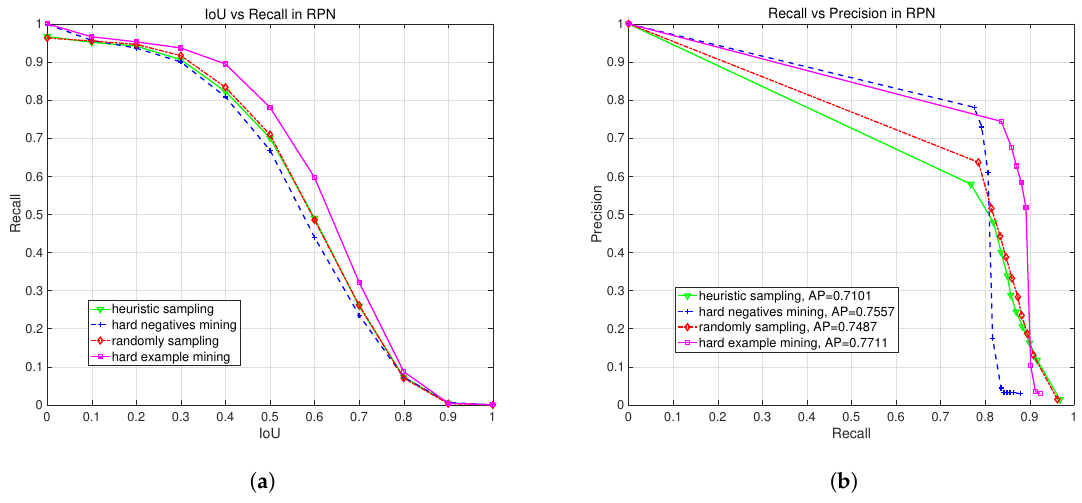
Figure 9. Comparison of the different sampling methods on region proposal. ( a ) IoU-Recall Curve in RPN; ( b ) Precision-Recall curve in